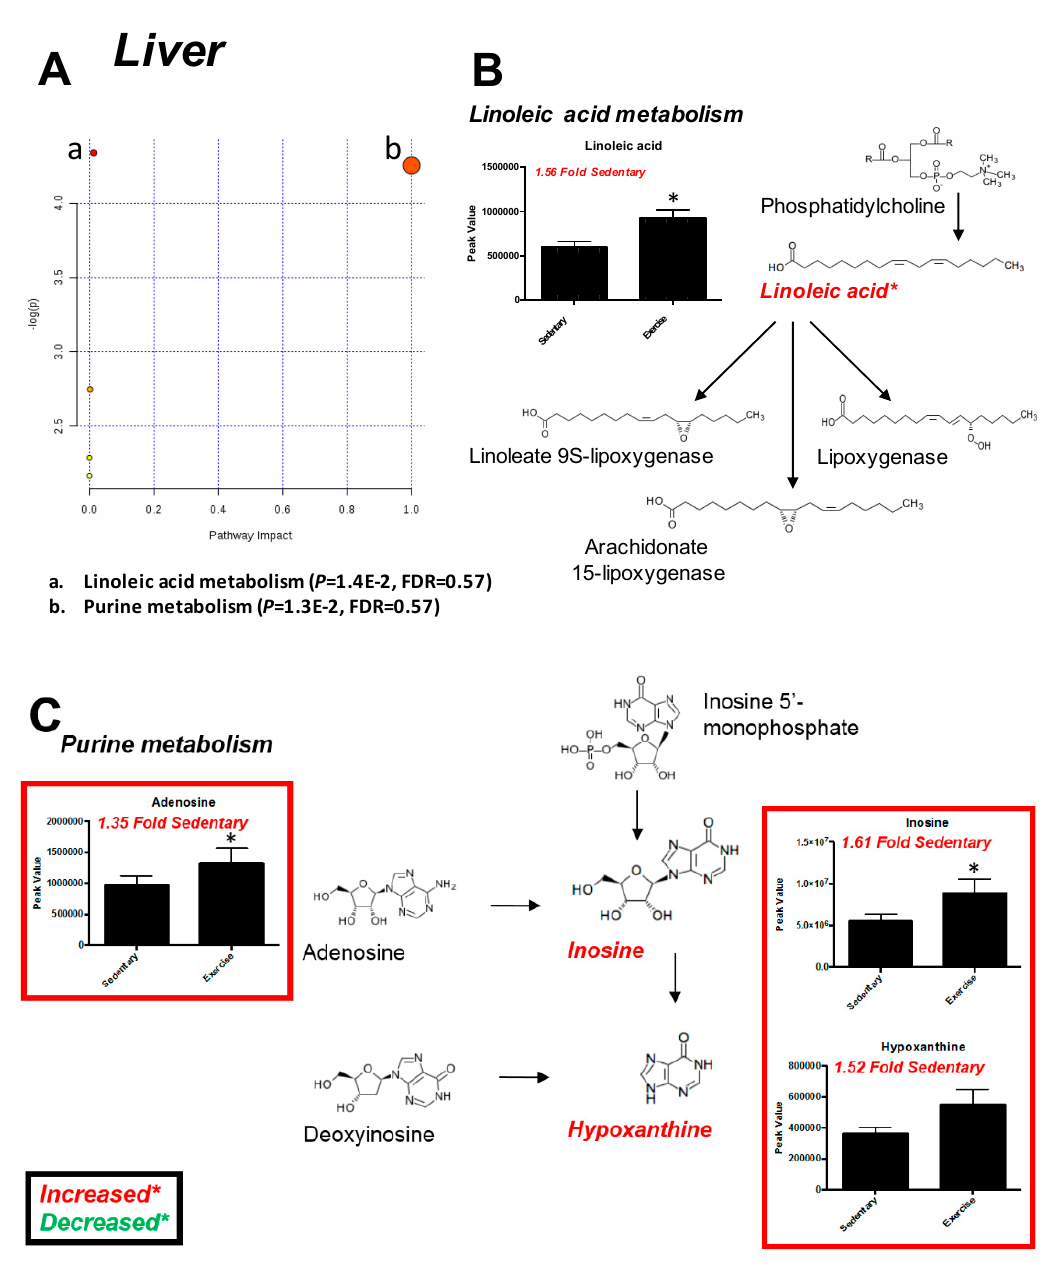
Figure 6. Pathway analysis of t -test significant liver metabolites from exercise-trained vs. sedentary control rat livers. ( A ) Pathway analysis based on t -test significant metabolites. ( B ) t -Test significant metabolite related to linoleic metabolism. ( C ) t -Test significant metabolite related to purine metabolism. Data represent mean ± SEM. * P < 0.05. N = 12/group.